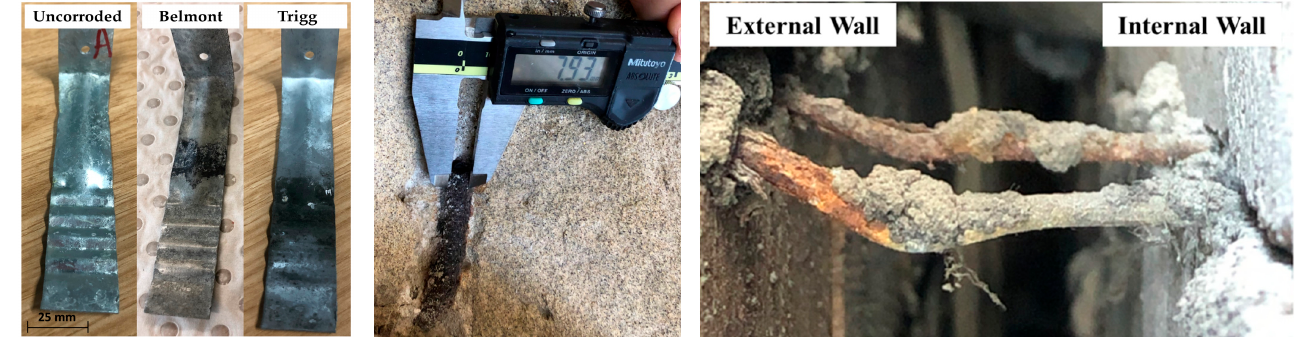
Figure 3. Comparative images of corroded metal wall fitments. Uncorroded control exposed at Belmont, NSW, and exposed at Trigg, WA, (R3) 470 g/m 2 Galvanised veneer wall ties ( left ); BHP round bar steel fitment used for masonry façade fixings at the Newcastle City Councill Heritage building ( center ); and comparative external wall metal tie corrosion of a 1960 ′ s multi-story cavity masonry residential building in Sydney ( right ) [19].